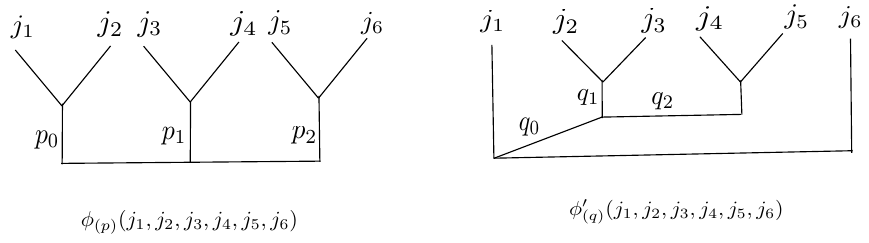
Figure 17 . Two di(cid:11)erent basis for 6-point conformal